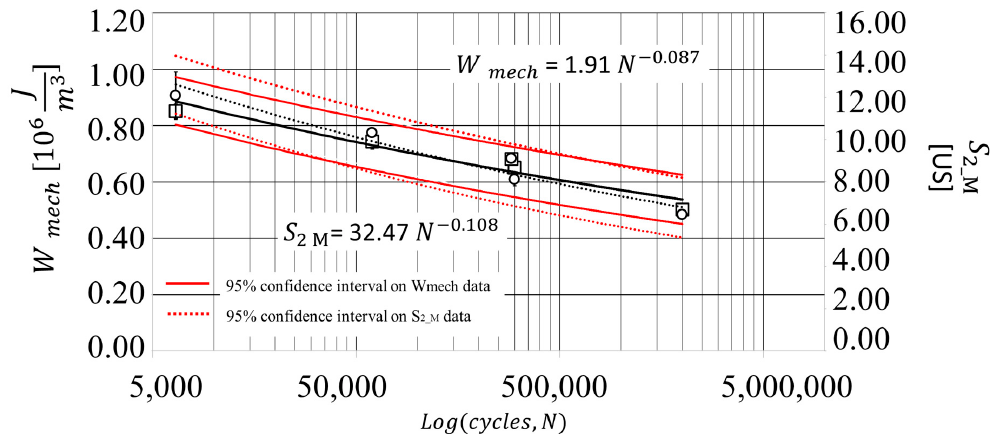
Figure 8. Comparison between W mech and S 2 _M versus loading cycles N , with standard error bars and confidence levels.